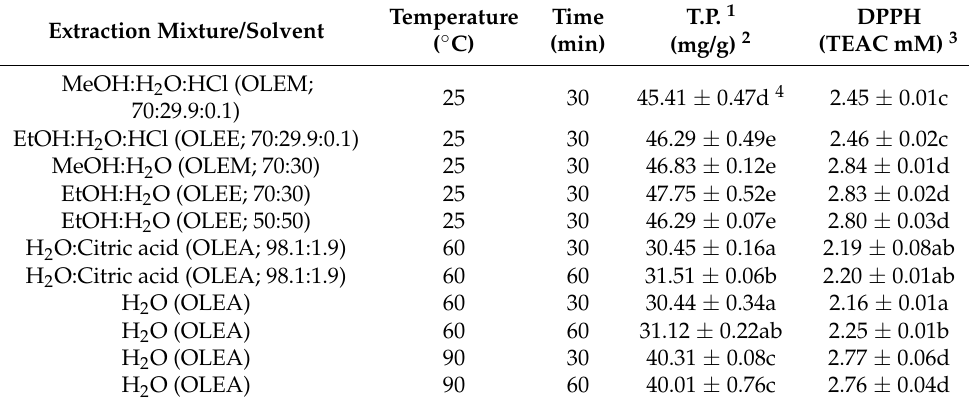
Table 2. Total polyphenol content and DPPH activity of the different olive